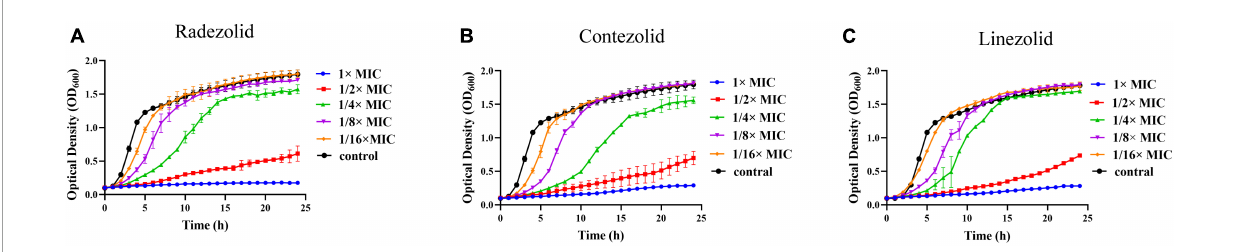
FIGURE2 Effect of oxazolidinone antibiotics on the planktonic growth of S. aureus . The optical density (OD 600 ) of S. aureus YUSA145 at subinhibitory concentrations (1/2 × MIC, 1/4 × MIC, 1/8 × MIC, and 1/16 × MIC) of radezolid (A) , contezolid (B) , and linezolid (C) was determined using the automatic growth curve method. The presented data were the average of three independent experiments (mean ± SD).